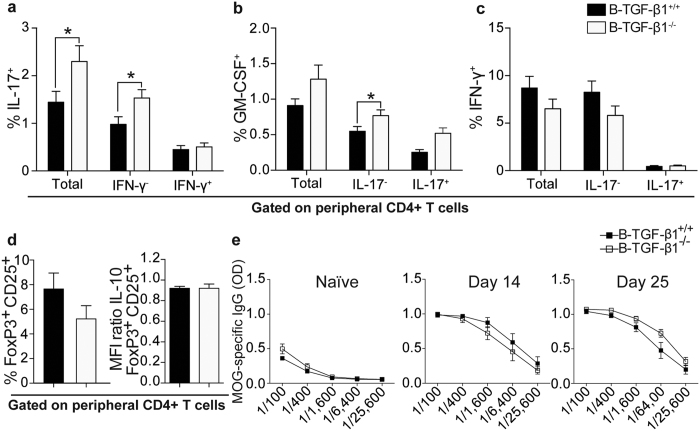
B cell-derived TGF-β1 expression restrains the in vivo development of Th17 responses.(a–e) Splenocytes from B–TGF-B1+/+ and B–TGF-B1−/− EAE mice collected at the acute phase of the disease were stimulated in vitro with PMA/Ionomycin for 4 hrs and incubated with Brefeldin A and stained for CD3, CD4, CD25, FoxP3 and intracellular cytokines. Tabulated results from all mice are presented as percentage of live CD3+CD4+ T cells in the spleen. (a) Total: all IL-17+ cells; IFN-γ−: IL-17+IFN-γ− cells; IFN-γ+: IL-17+IFN-γ+ cells. (b) Total: all GM-CSF+ cells; IL-17−: GM-CSF+IL-17− cells; IL-17+: GM-CSF+IL-17+ cells. (c) Total: all IFN-γ+ cells; IL-17−: IFN-γ+IL-17− cells; IL-17+: IFN-γ+IL-17+ cells. (d, left) Frequencies of CD4+CD25+FoxP3+ Tregs. (d, right) Quantification of intracellular IL-10 production in Tregs. Results are reported as relative (ratio) geometric MFI value. Results are presented as mean ± SEM (n = 11) (*P < 0.05 by Student’s t-test). Results are a composite of 2 independent experiments with comparable results. (e) Sera from individual naive and immunized (rmMOG) B–TGF-B1+/+ and B–TGF-B1−/− mice were obtained on days 14 and 25 after immunization, and serum MOG-specific IgG levels were calculated. MOG-specific IgG titers are expressed as mean OD values ± SEM from one of three representative experiments (performed in triplicate) from 1:4 serial dilutions.